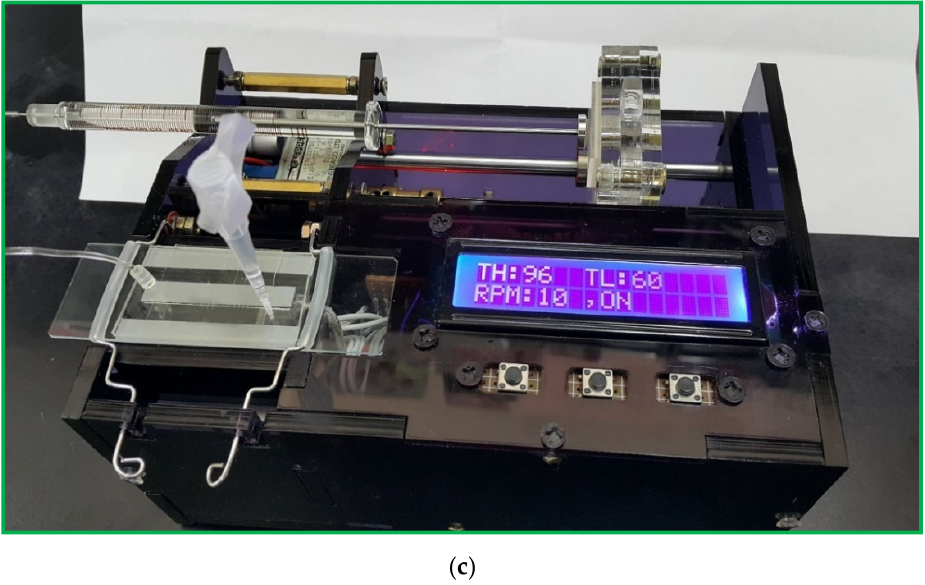
Figure 1. ( a ) A schematic diagram of the portable CFPCR device. Photographic images of the portable CFPCR device ( b ) with outer casing and ( c ) without outer casing.